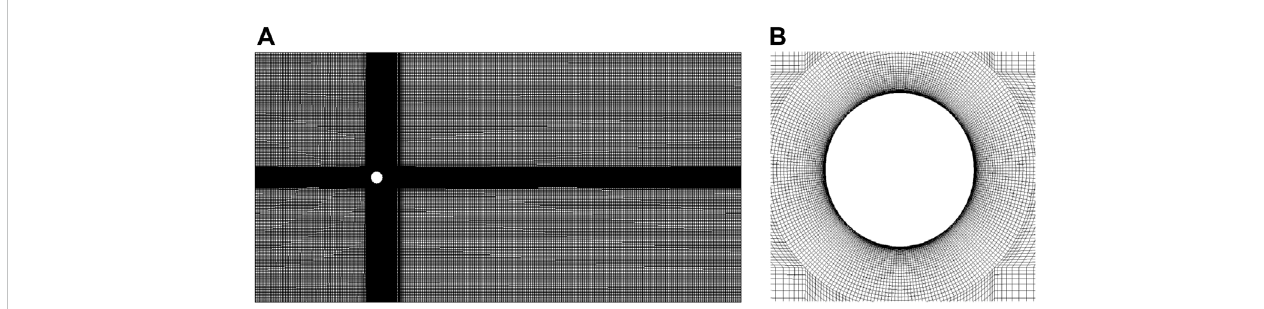
FIGURE 2 Computational mesh for the circular cylinder: (A) entire domain; (B) near-wall region.